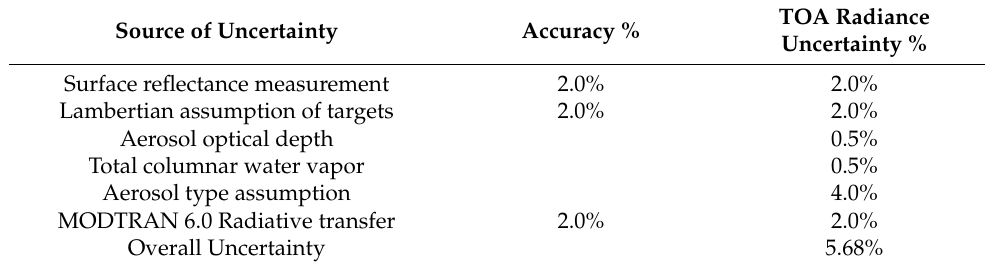
Table 6. Sources of uncertainties in TOA radiance in the reflectance-based